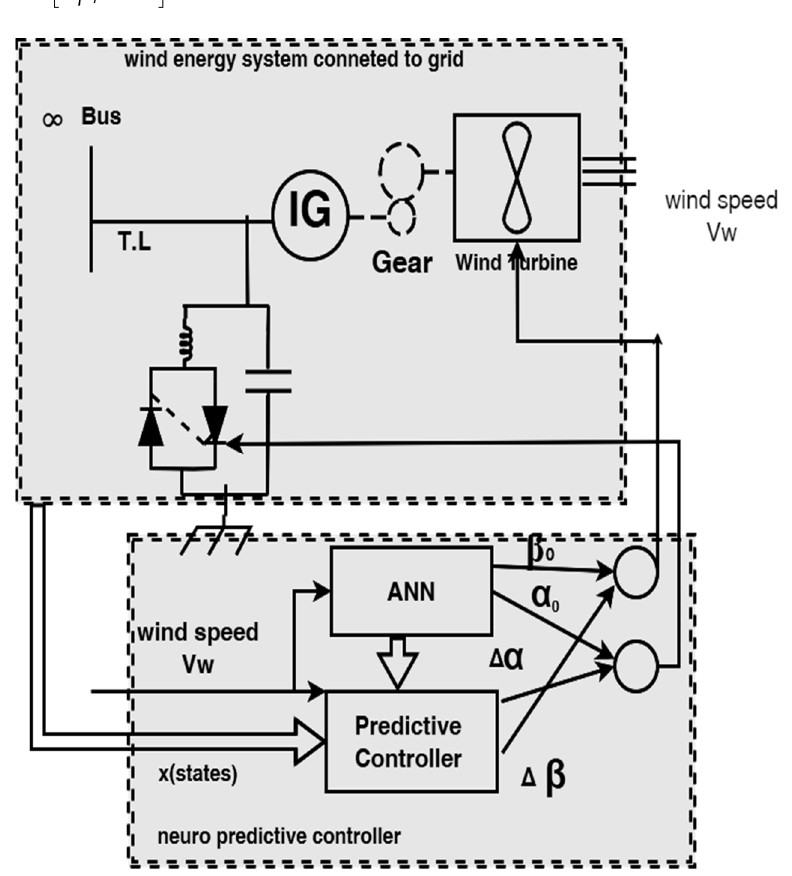
Figure 3. Neuro-Predictive configuration for controlling the WECS.